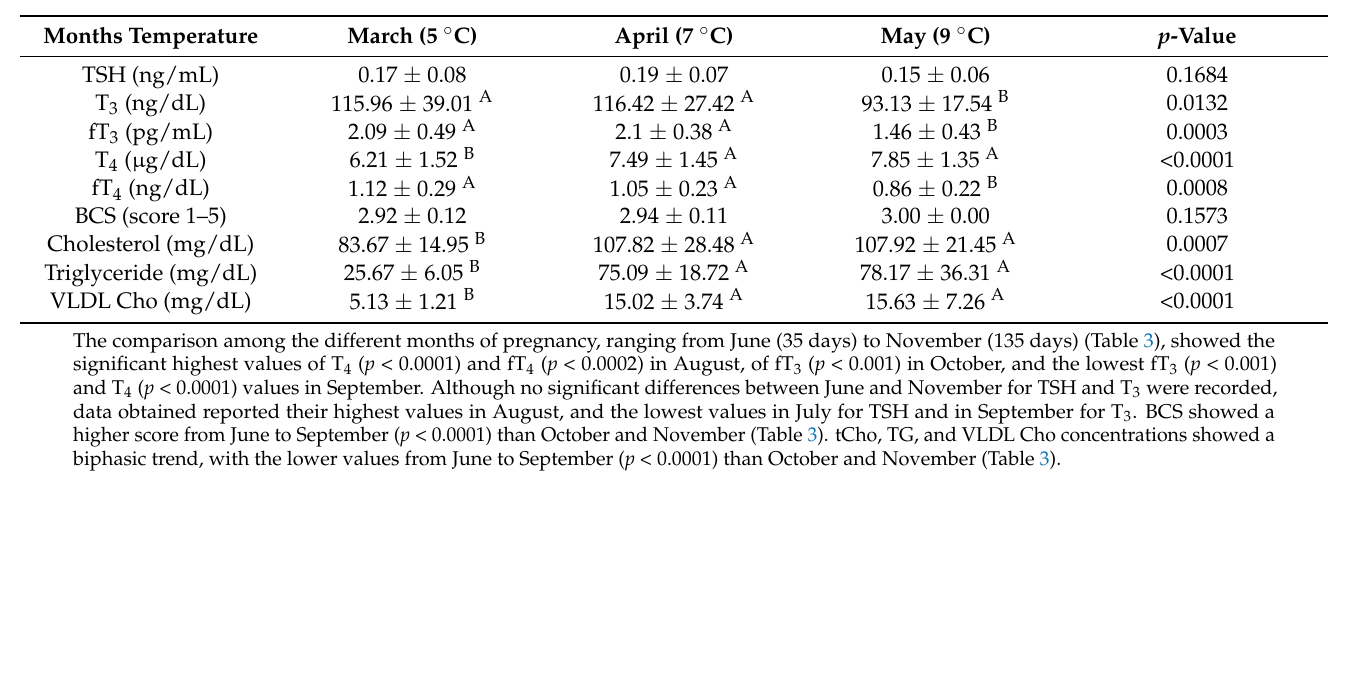
Table 2. Circulating thyroid-stimulating hormone (TSH), total and free triiodothyronine (T 3 , fT 3 ), total and free thyroxine (T 4 , fT 4 ) concentrations, body condition score (BCS), and lipidic panels (mean ± sd) in nonpregnant periods of 30 Nicastrese goats. Within each row, different superscript letters indicate significantly different values. Temperature measurements refer to the environmental temperature at the sampling